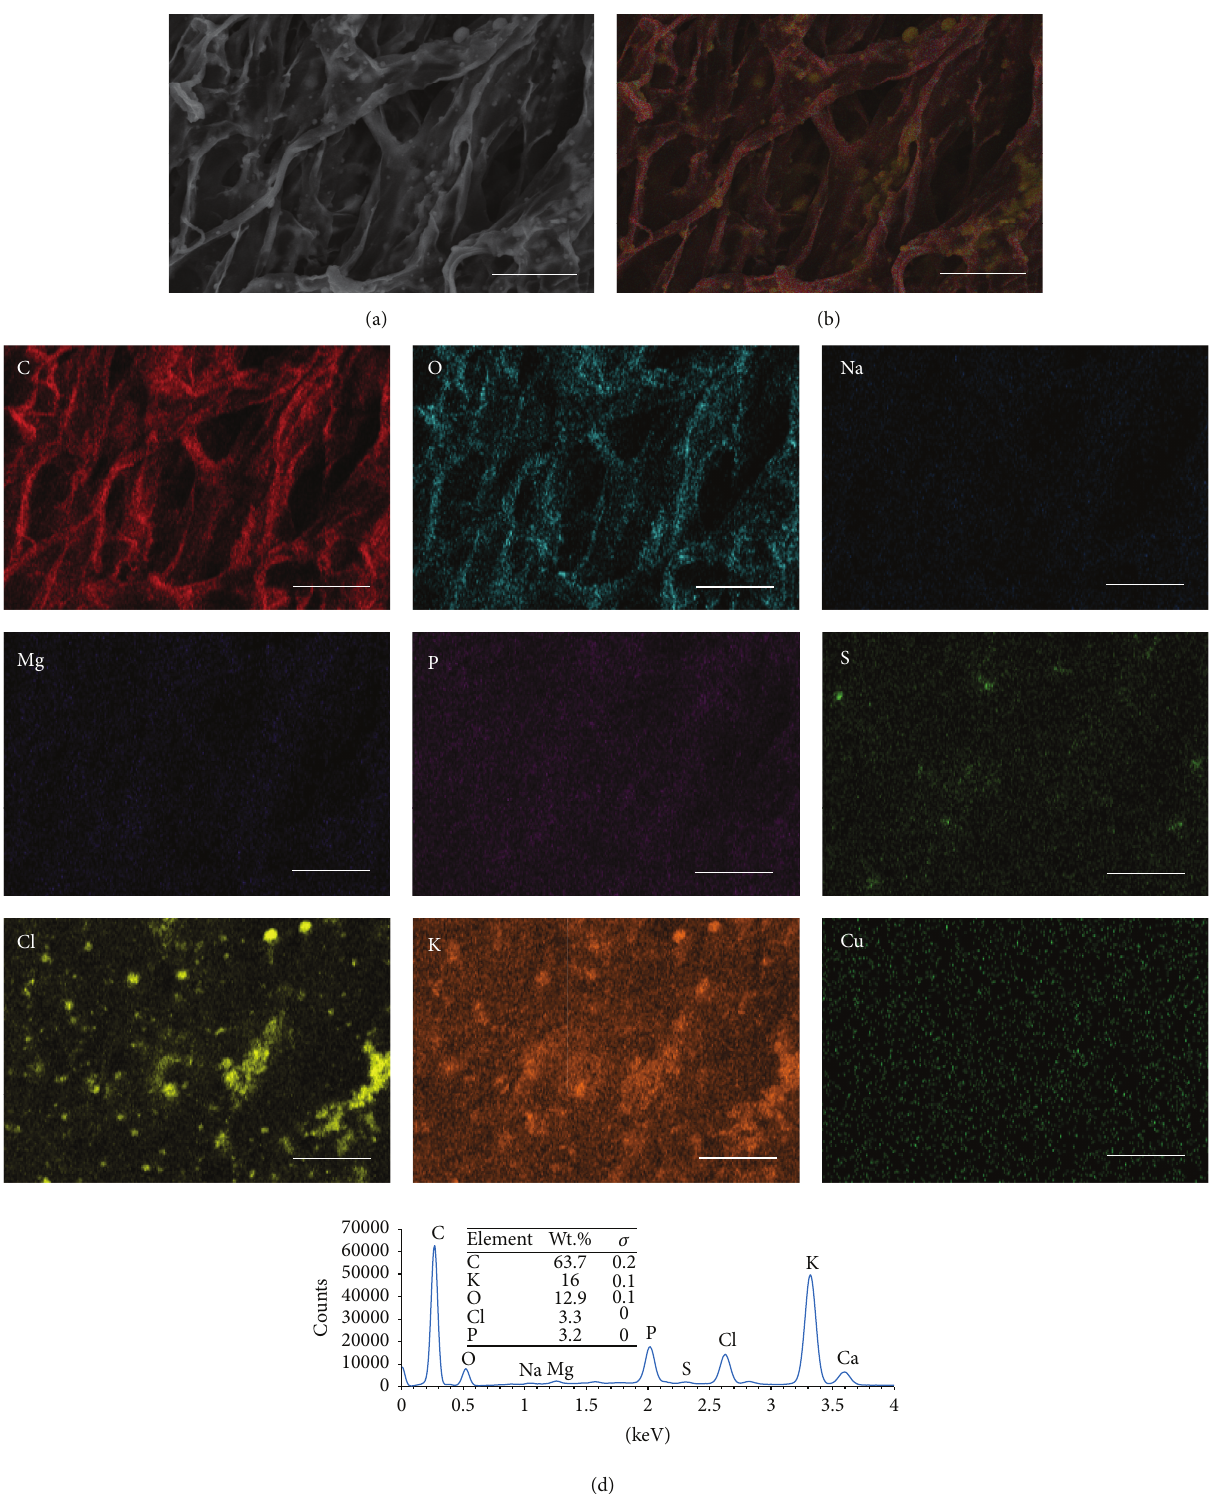
Figure 3: Elemental mapping of CT before DI H 2 O wash, including the raw electron image (a), composite image (b), and maps of most prominent elements in the specimen (all scale bars = 25 𝜇 m), with accompanying EDS spectrum